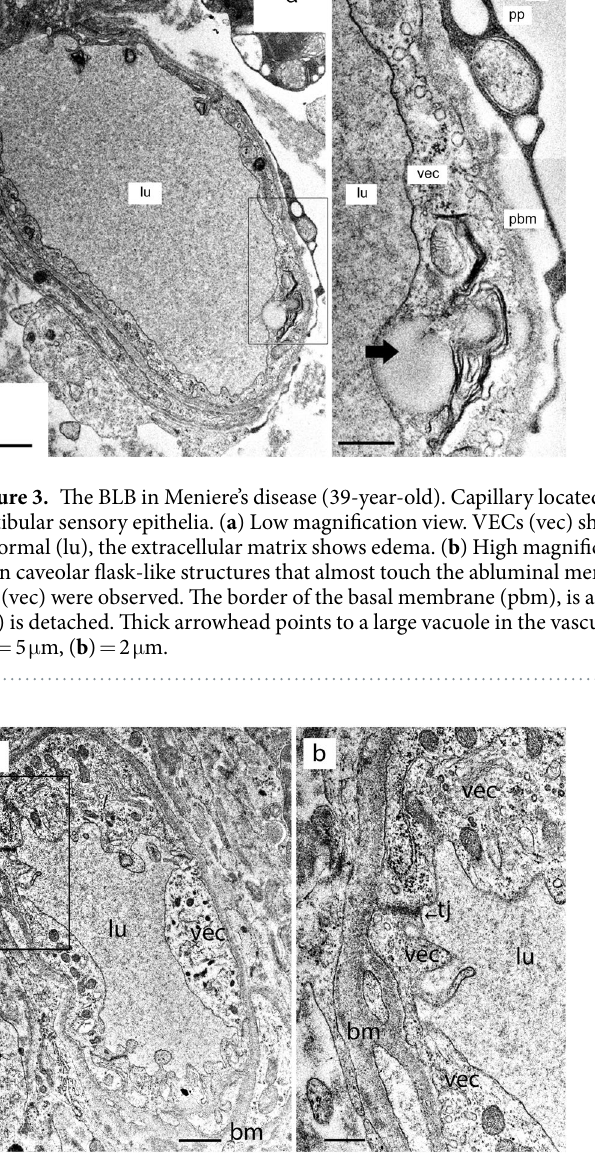
Figure 4. A BLB capillary in Meniere’s disease (82-year-old). Capillary located in the utricle stroma underneath the vestibular sensory epithelia. ( a ) Low magnification view. The vascular endothelial cell (vec) is swollen with degeneration of organelles and debris within the cytoplasm, the lumen (lu) is uneven and narrowed with pseudopodic and microvilli-like projections, the perivascular basement membrane (bm) exhibits mild thickening. ( b ) High magnification view (from fig a) of the vascular endothelial cell (vec). The tight junction (tj) appears normal, bm: basement membrane. Bar ( a ) = 1 μ m, ( b ) = 0.5 μ